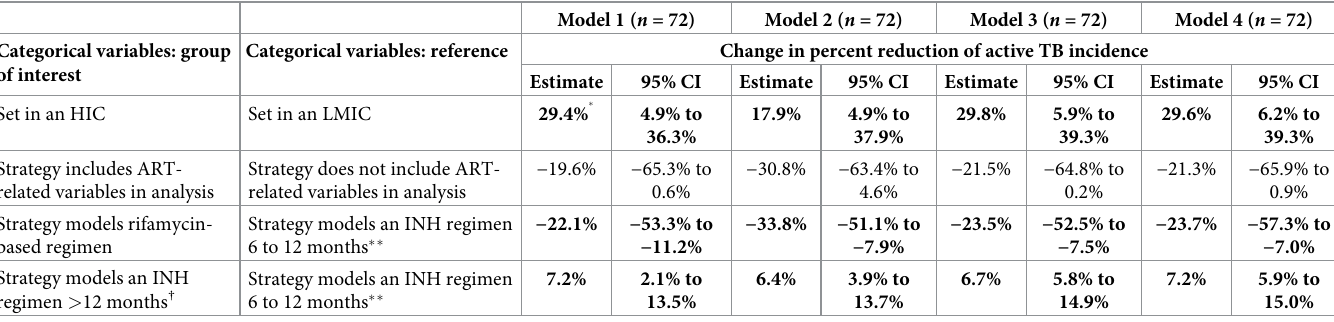
Table 3. Multivariable regression models: percent reduction in active TB incidence comparing TPT to no